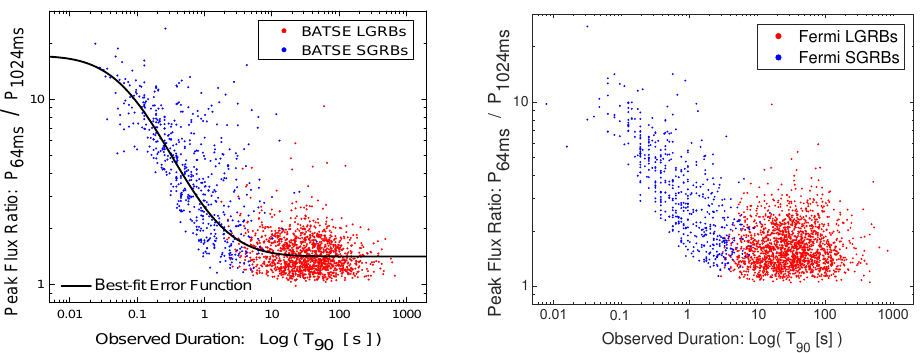
Figure 3. An illustration of the similar effects of different triggering timescales on the detectabil- ity of GRBs in BATSE and Fermi catalogs: SGRBs are more detectable than LGRBs at shorter triggering